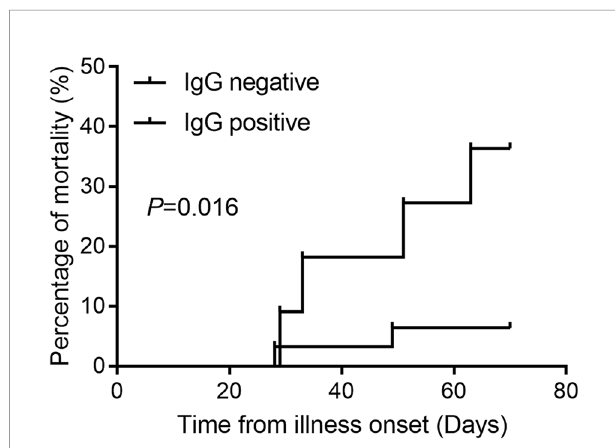
FIGURE 1 | Cumulative mortality events in critical COVID-19 with and without IgG antibody response.